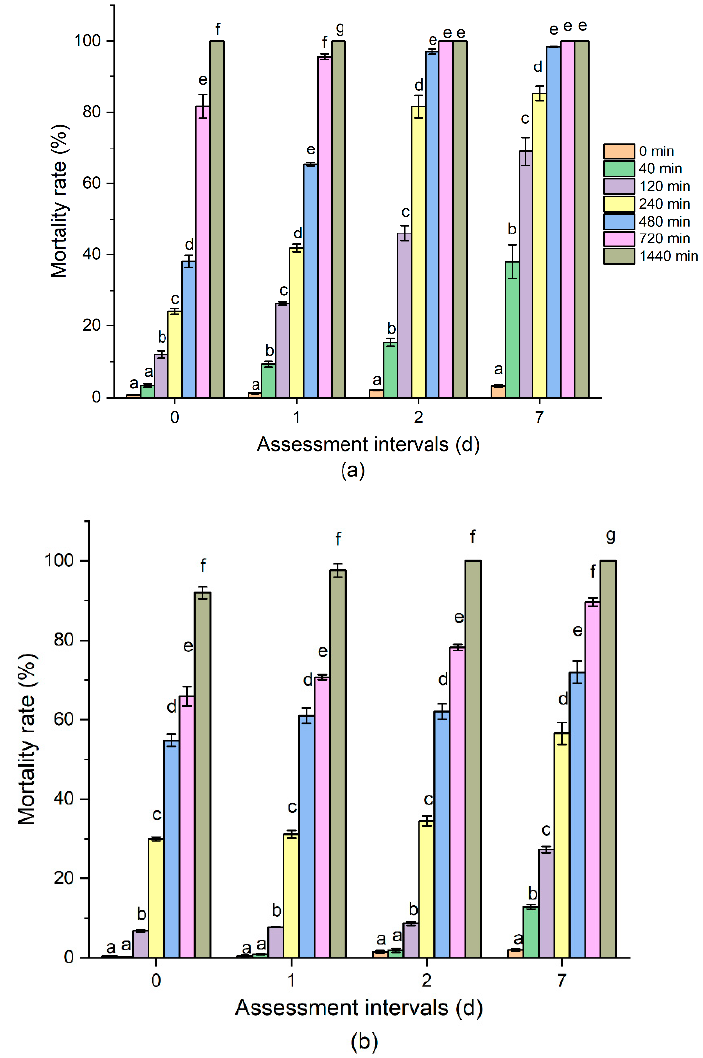
Figure 1. The mortality rate of ( a ) Rhyzopertha dominica and ( b ) Tribolium castaneum to different O 3 exposure times at 0, 1, 2, and 7 days after O 3 treatment. The bars with different letters (a–g) are significantly different (Tukey’s HSD test, p < 0.05). Table 1. Regression analysis for mortality rate of Rhyzopertha dominica and Tribolium castaneum at different assessment intervals. 700 ppm ozone of each treatment time (0, 40, 120, 240, 480, 960, and 1440 min) for two species were conducted.